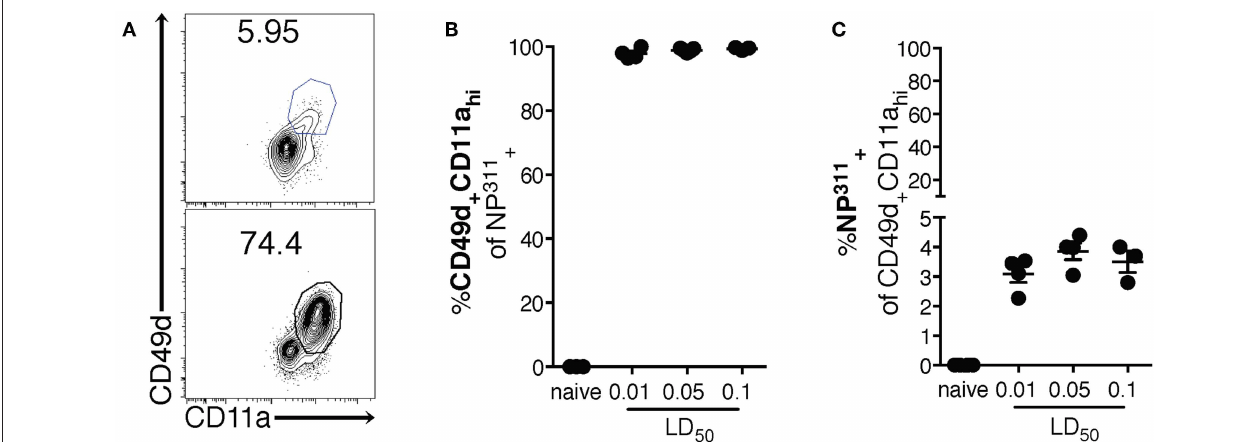
FIGURE 2 | The majority of pulmonary NP 311 -specific CD4T cells in the lungs are CD49d + CD11a hi however NP 311 -specific CD4T cells only account for a small fraction of the total IAV-specific CD4T cell response. Mice were infected with a 0.1LD 50 , 0.05LD 50 , or 0.01LD 50 dose of IAV-PR8 and the lungs were harvested and analyzed for NP 311 specificity (B,C) and CD49d + CD11a hi expression (A–C) at day 7 p.i.. Shown are the representative plots of CD49d + CD11a hi cells of CD4 + in naïve and 0.05LD 50 IAV-infected mice (A) , the frequency of CD49d + CD11a hi of CD4 + NP 311 -tetramer + cells (B) , or NP311-tetramer + cells of CD4 + CD49d + CD11a hi gated cells (C) . Each point represents one mouse and mean and SEM are shown. Data are from one experiment, n = 3–4 mice per dose of